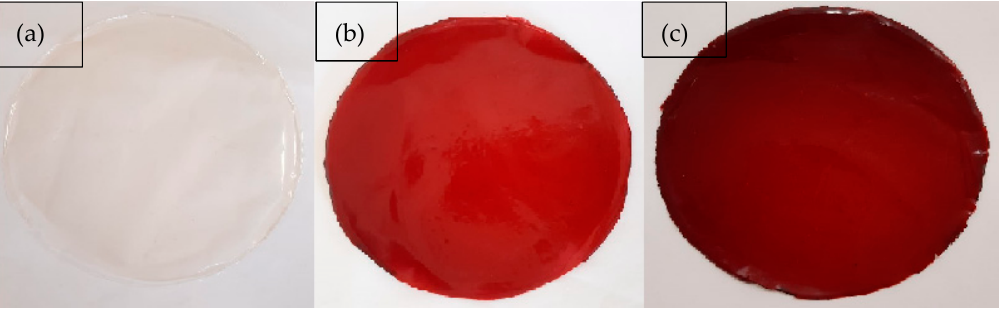
Figure 1. The visual appearance of carrageenan biodegradable films: ( a ) CAR-control, ( b ) CAR-50% JPE and ( c ) CAR-100% JPE.